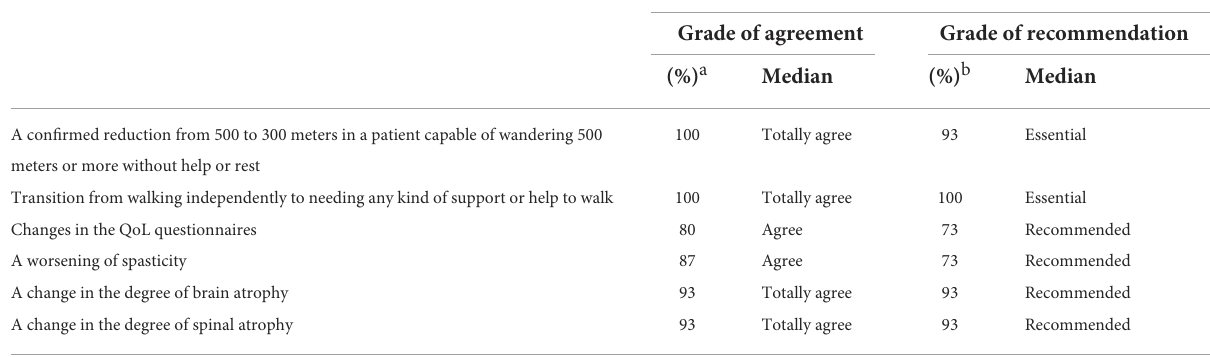
TABLE 3 Variables whose isolated change indicates that more accurate progression diagnostic tools should be